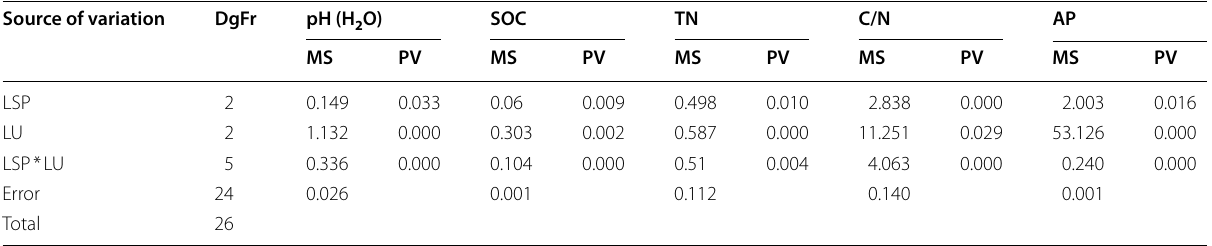
MS is the mean square, PV is the p-value, DgFr is the degree of freedom